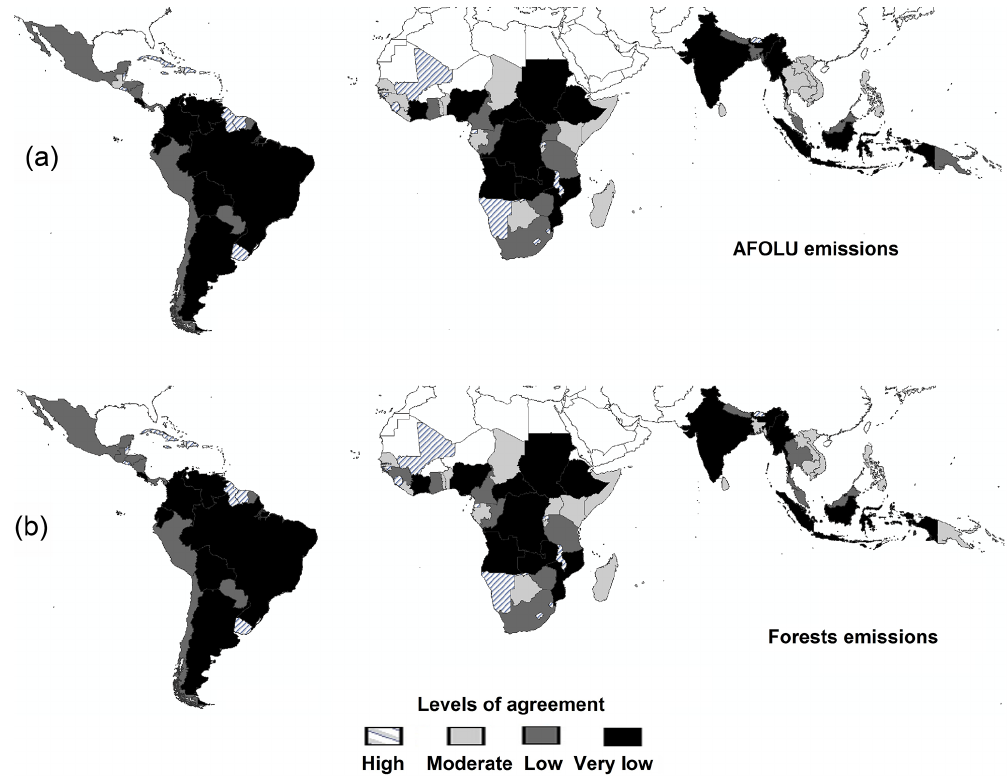
Figure 7. Country-level agreement for (a) AFOLU and (b) forest emissions for the FAOSTAT, EDGAR, and Hotspots datasets, The categories of agreement are percentiles of the standard deviations which represent a measure of data variability. High agreement corresponds to low data variability ( ≤ 25th percentile), moderate agreement to 25th–50th percentiles, low agreement to 50th–75th percentiles and very low agreement to ≥ 75th percentile, which corresponds to very high data